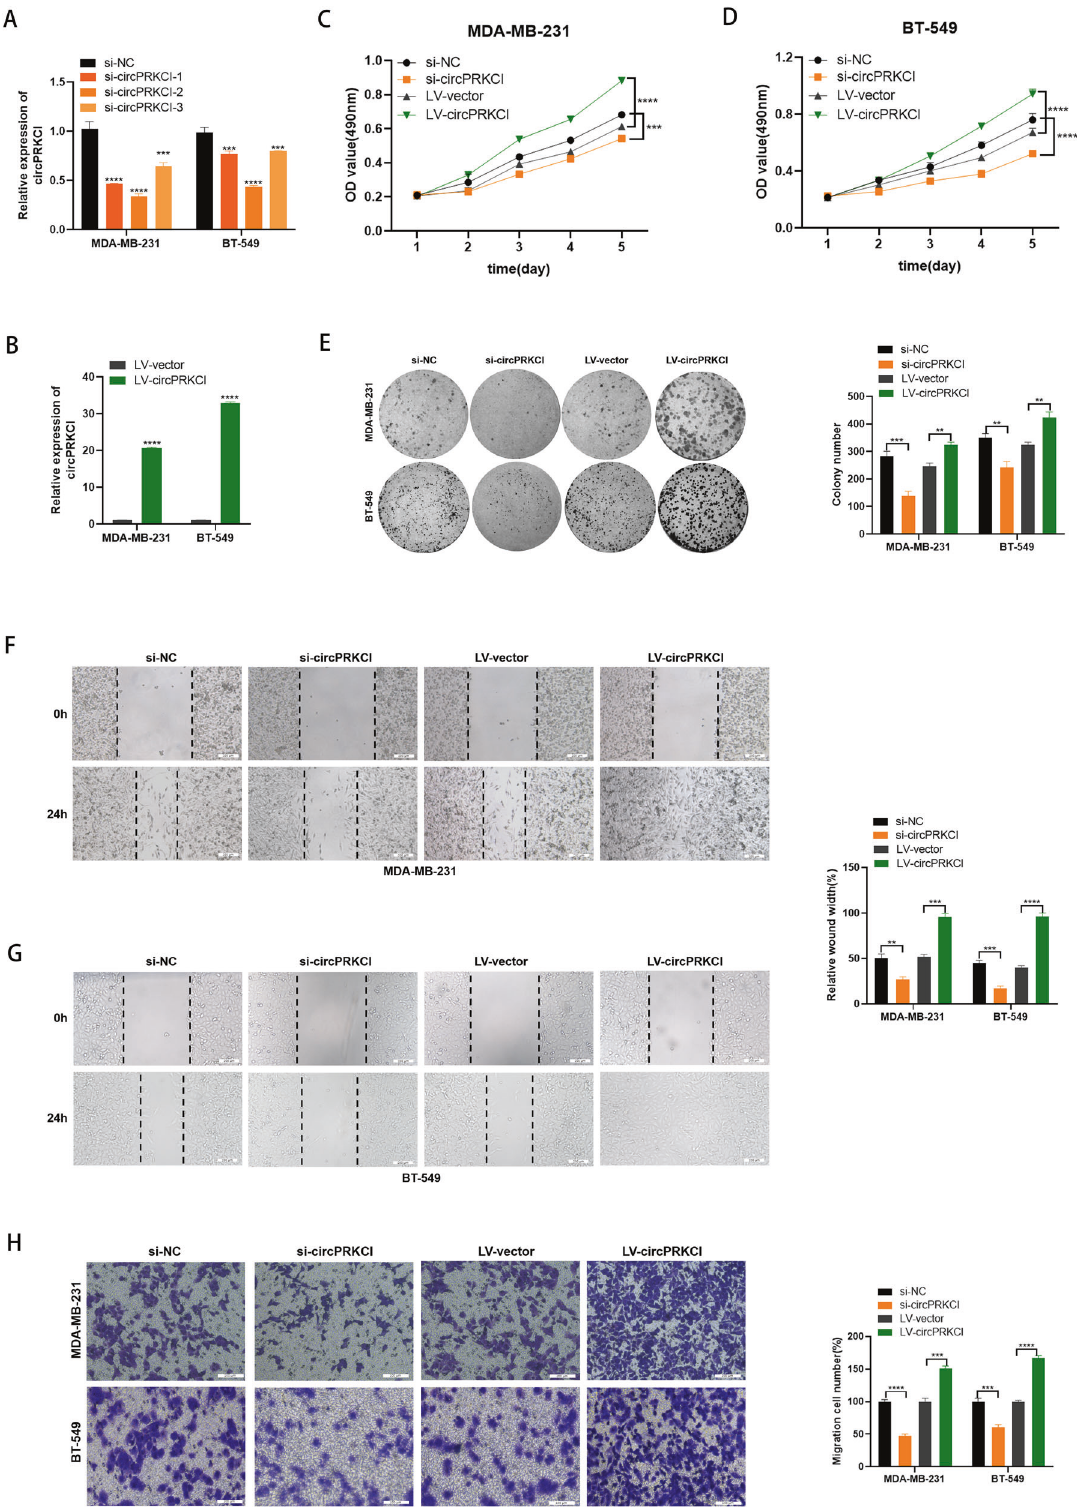
Fig. 2 CircPRKCI exerted oncogenic role in TNBC cells. A Expression of circPRKCI was con fi rmed by qRT-PCR in BC cells transfected with si- NC or si-circPRKCI. B Expression of circPRKCI was con fi rmed by qRT-PCR in BC cells transfected with LV-vtctor or LV-circPRKCI. C , D Effect of si- circPRKCI and LV-circPRKCI on proliferation in TNBC cells by MTT assay. E Effect of si-circPRKCI and LV-circPRKCI on proliferation in TNBC cells by colony formation assay. F – G Effect of si-circPRKCI and LV-circPRKCI on migration in TNBC cells by wound healing assay. H Effect of si- circPRKCI and LV-circPRKCI on migration in TNBC cells by cell migration assay. ** p < 0.01,*** p < 0.001,**** p < 0.0001.